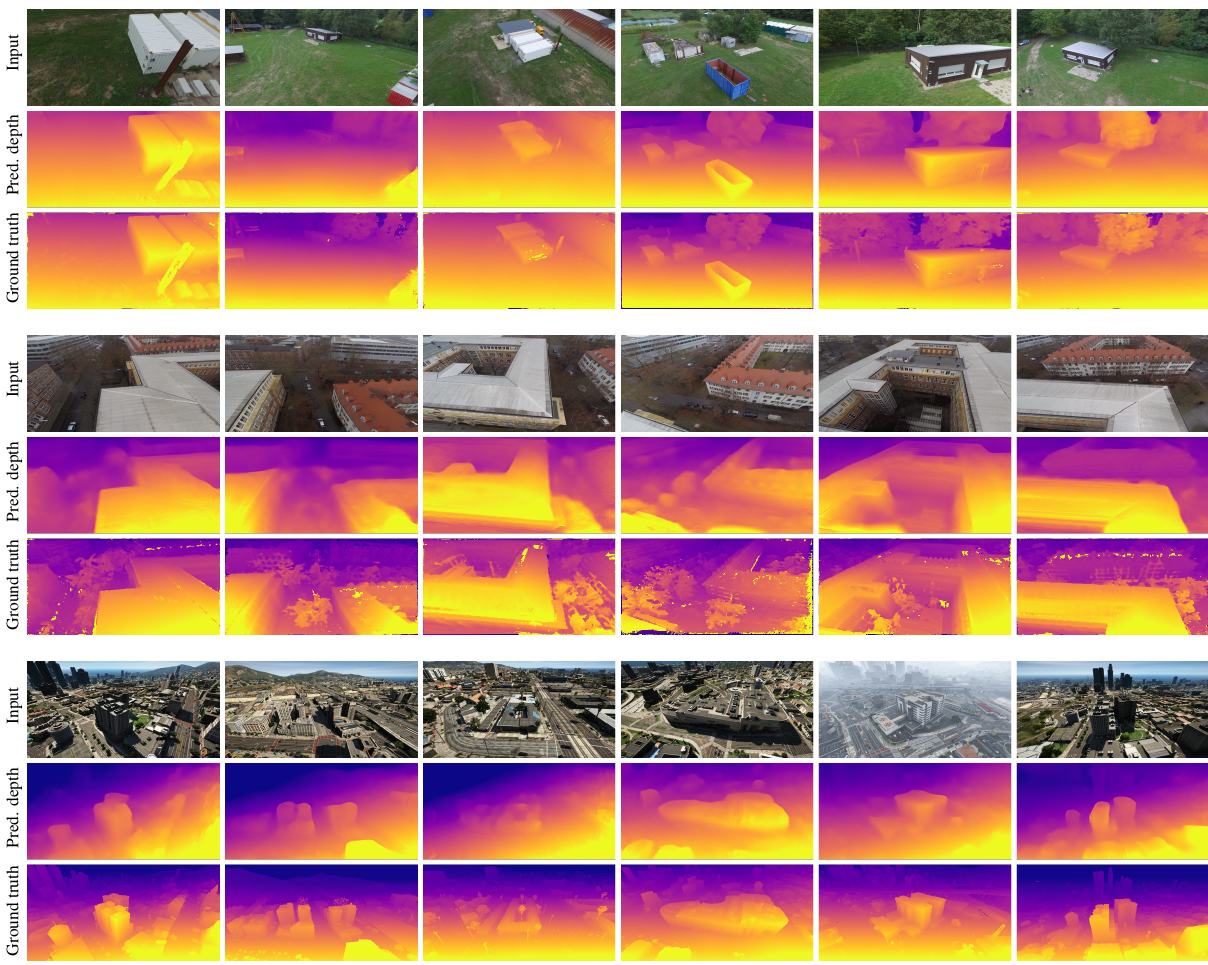
Figure 4. Qualitative results on all three datasets - from top to bottom: rural , urban and synthetic . The first row of each bundle shows the reference image for which the depth map is predicted. The second row depicts the depth map that is predicted by the presented SMDE approach. In the last row, the corresponding ground truth depth map is shown. In the case of the two real-world datasets, this is calculated by means of COLMAP.